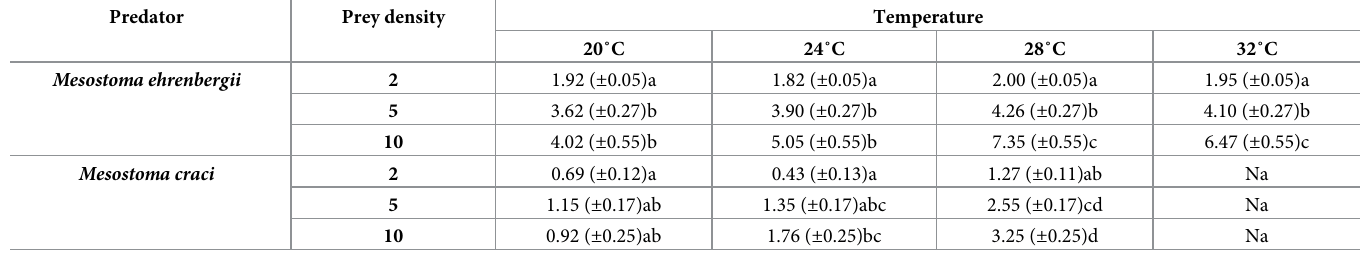
Table 2. Mean predation rates (± standard errors) of Mesostomaehrenbergii and Mesostomacraci on Daphnia similis at different temperatures and prey density combinations, over the period of 10 days.